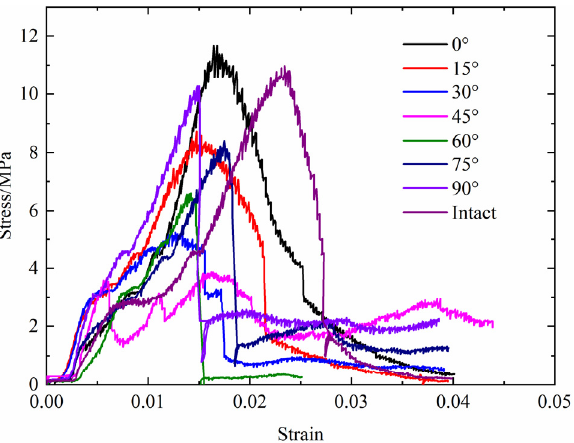
Figure 3. Stress–strain curves of specimens with different prefabricated crack angles.